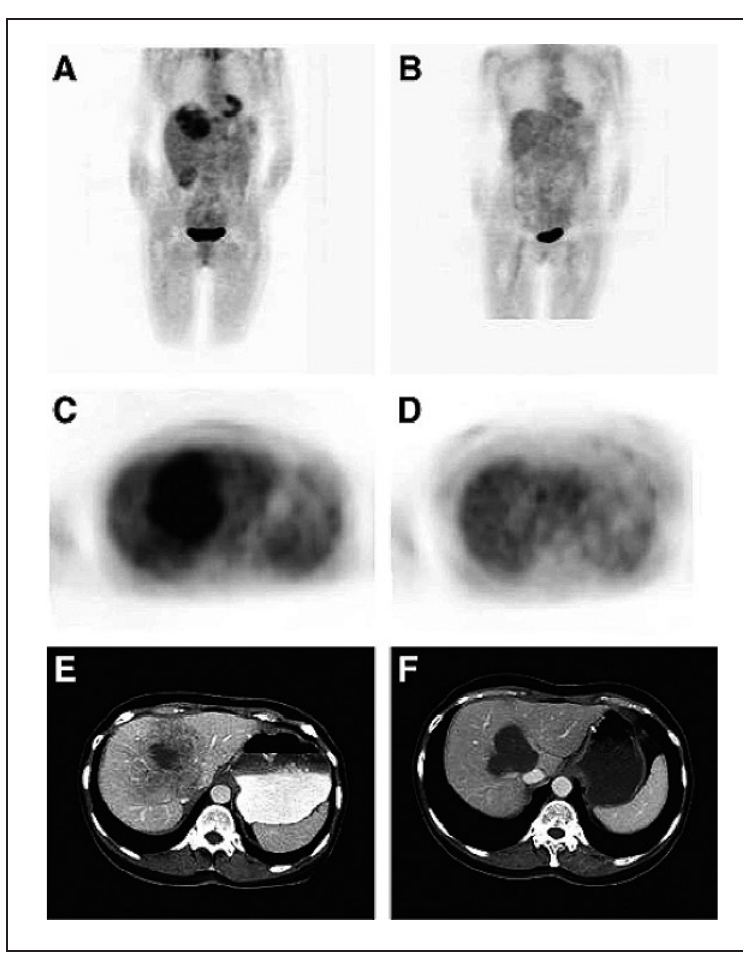
18 FDG-PET can detect imatinib response earlier than CT. 18 FDG-PET scans (A, C) and a CT scan (E) with large tumour metastases in the liver one year after resection, before the start of imatinib therapy. 18 FDG -PET (B, D) and CT (F) imaging evaluations after two months of imatinib therapy. No pathological FDG uptake can be observed in the liver. However, residual tumour on the CT scan remains considerable. From [110], with permission from AlphaMed Press, 318 Blackwell Street, Suite 260, Durham, NC 27701,